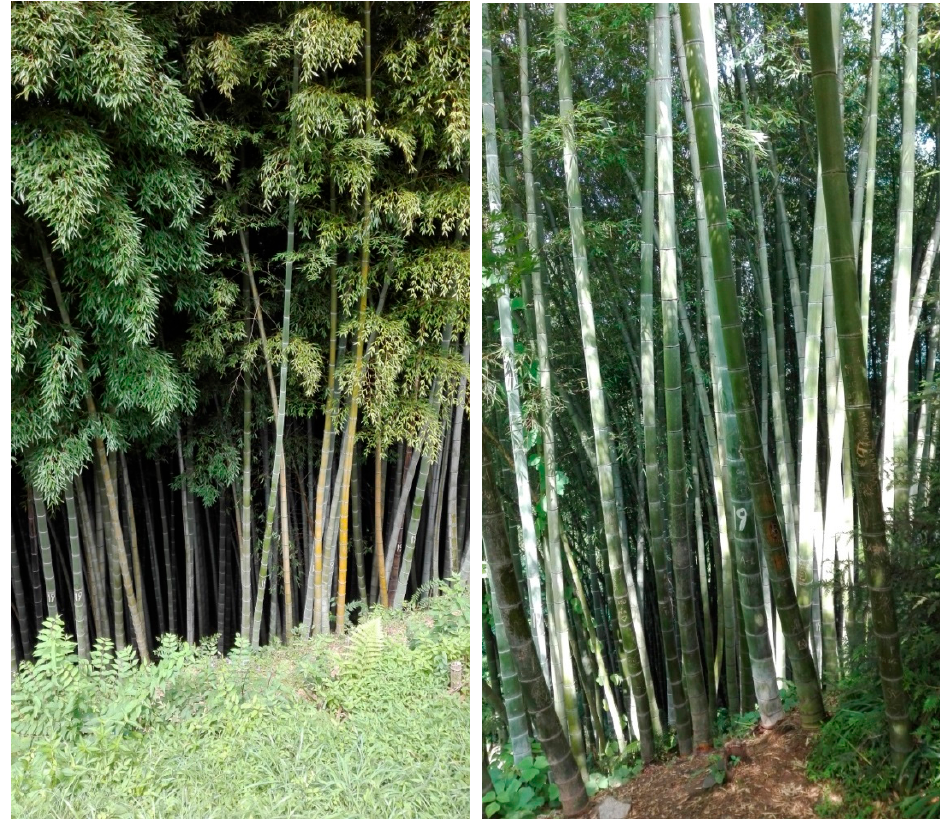
Figure 2. Moso bamboo. Sources: Author’s photo archive ( Phyllostachys pubescens Moso Bamboo).